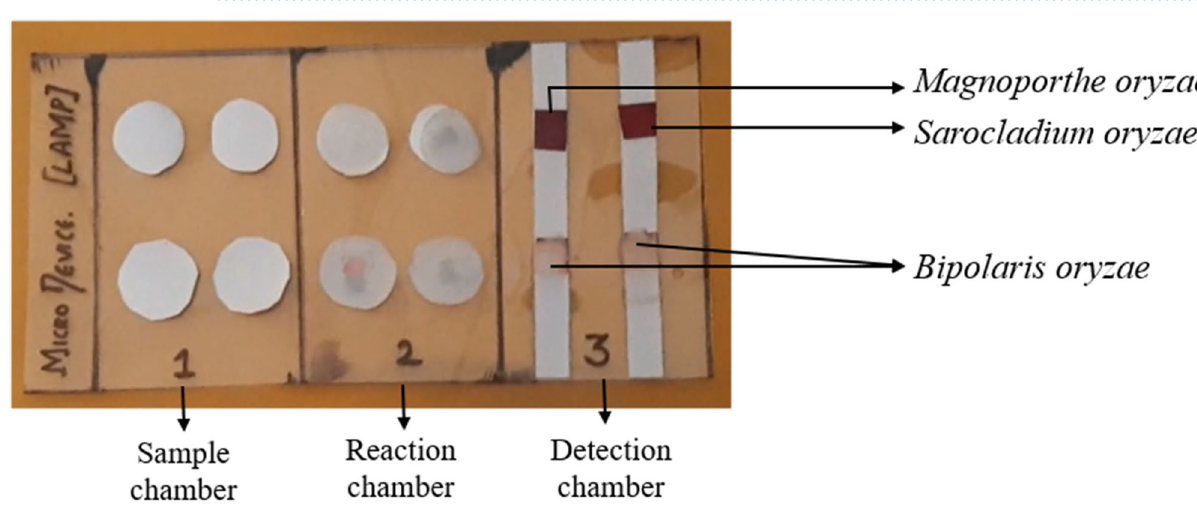
Figure 6. Detection of Magnaporthe oryzae and Sarocladium oryzae on foldable membrane microdevice platform. The result was visualized using basic fuchsin